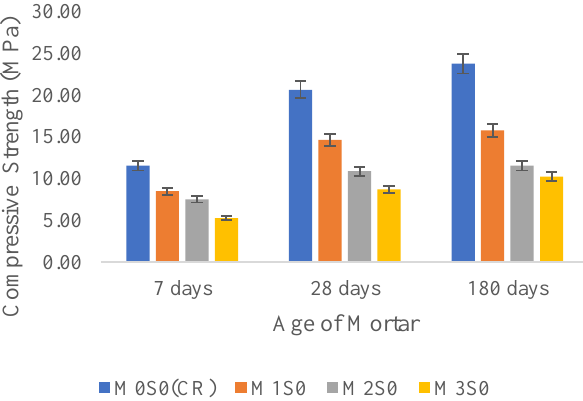
Figure 9. Effects of SDPMF content on mortars’ compressive strength.